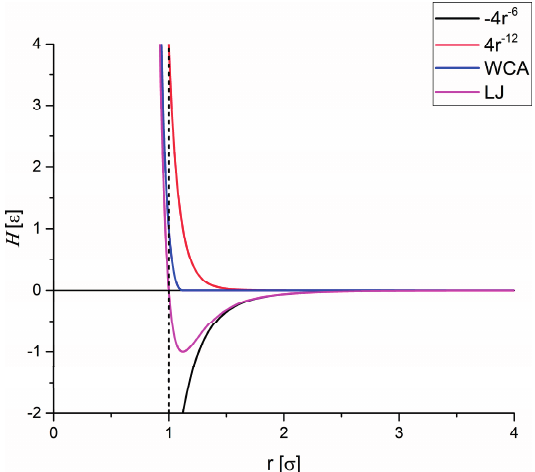
Figure 2. Comparison of attractive and repulsive Lennard-Jones (LJ) potential (magenta) and short-range repulsive Weeks-Chandler-Andersen (WCA) potential (blue) together with the dominating contributions 4 × (cid:1870) (cid:2879)(cid:2869)(cid:2870) (red) and −4 × (cid:1870) (cid:2879)(cid:2874) (black). Here, the respective potential ℋ which is given in units of energy is plotted as a function of the distance between two fictitious particles (cid:1870) given in units of